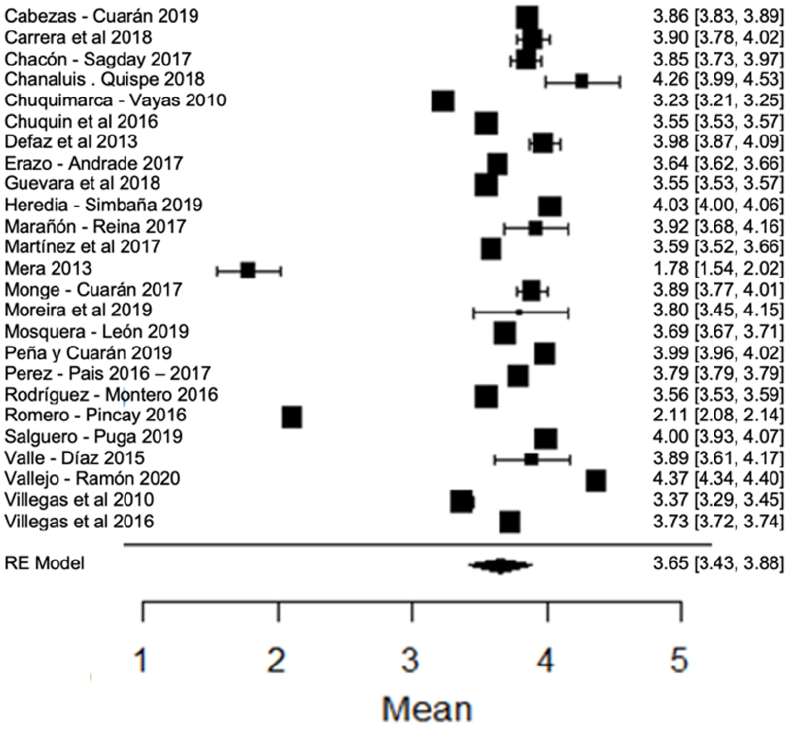
Figure 6. Forest plot of fat [14,16 – 18,21,23,24,26,28,33,35,38,39,42,44,51,53,57,60,61,63,76,77,79,80].